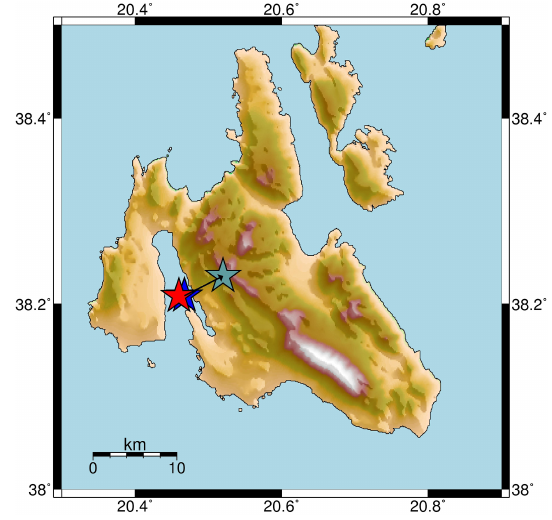
Figure 6. The epicenter of the strong earthquake ( M w = 6 . 0) on 26 January 2014 calculated with the 1-D model of Haslinger et al. (1999) (see Fig. 3) including distant phases (light blue star at the east), the same 1-D model excluding distant phases (blue star at the west), and the 2-D model (see Fig. 4) including distant phases (red